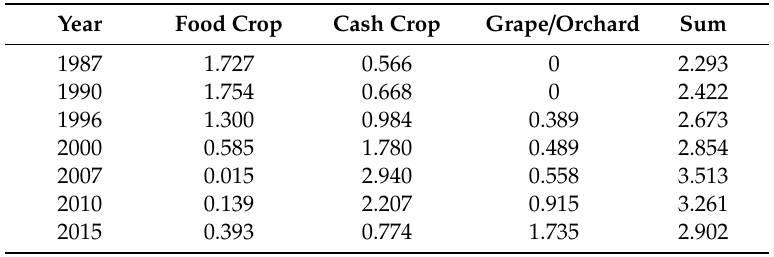
Table 3. Agricultural water consumption in 1987–2015 (10 8 m 3 ).